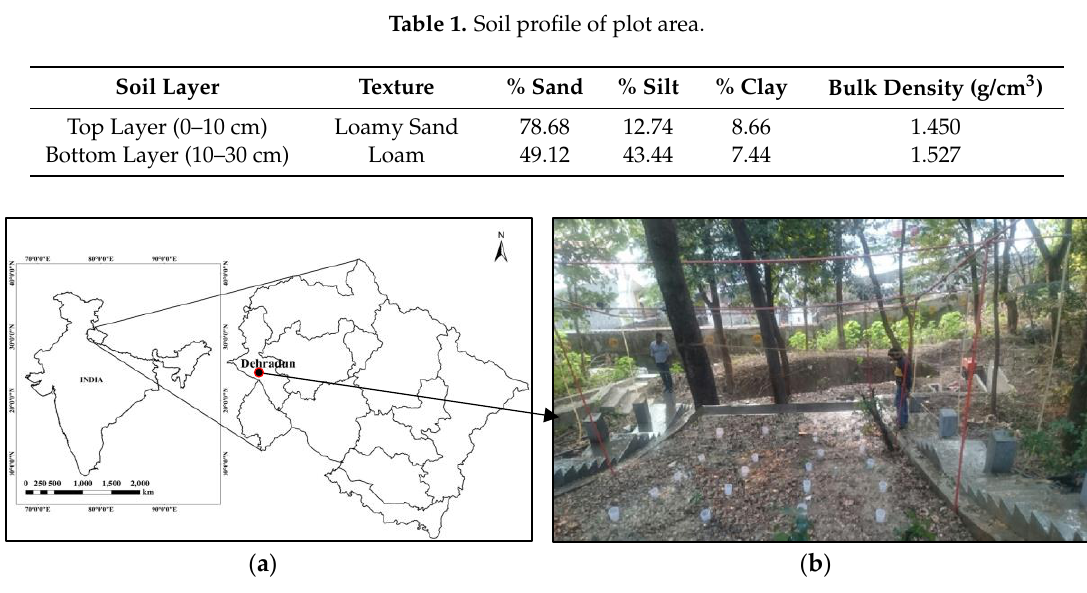
Figure 1. ( a ) Location of the study area; ( b ) Experimental hillslope plot setup.